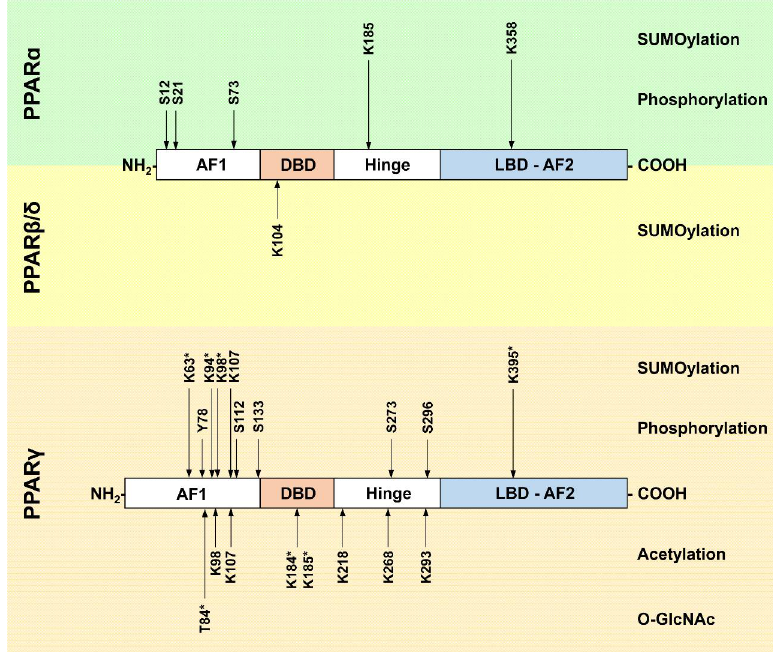
Figure 4. Post-translational modification sites in PPAR proteins. A schematic view of PPARα, PPARβ/δ, and PPARγ proteins and their functional domains is provided. The locations of PTM sites are indicated by arrows and the amino acid positions are given. Note that amino acids positions correspond to the murine proteins. For PPARγ, all amino acid positions refer to the PPARγ2 sequence; modifications which have so far only been described in PPARγ1 are highlighted with an asterisk. Ubiquitination events are not shown. AF1: activation function 1 domain; DBD: DNA-binding domain; Hinge domain; LBD-AF2: ligand binding and activation function 2 domain; K—lysine, S—serine, Y—tyrosine,